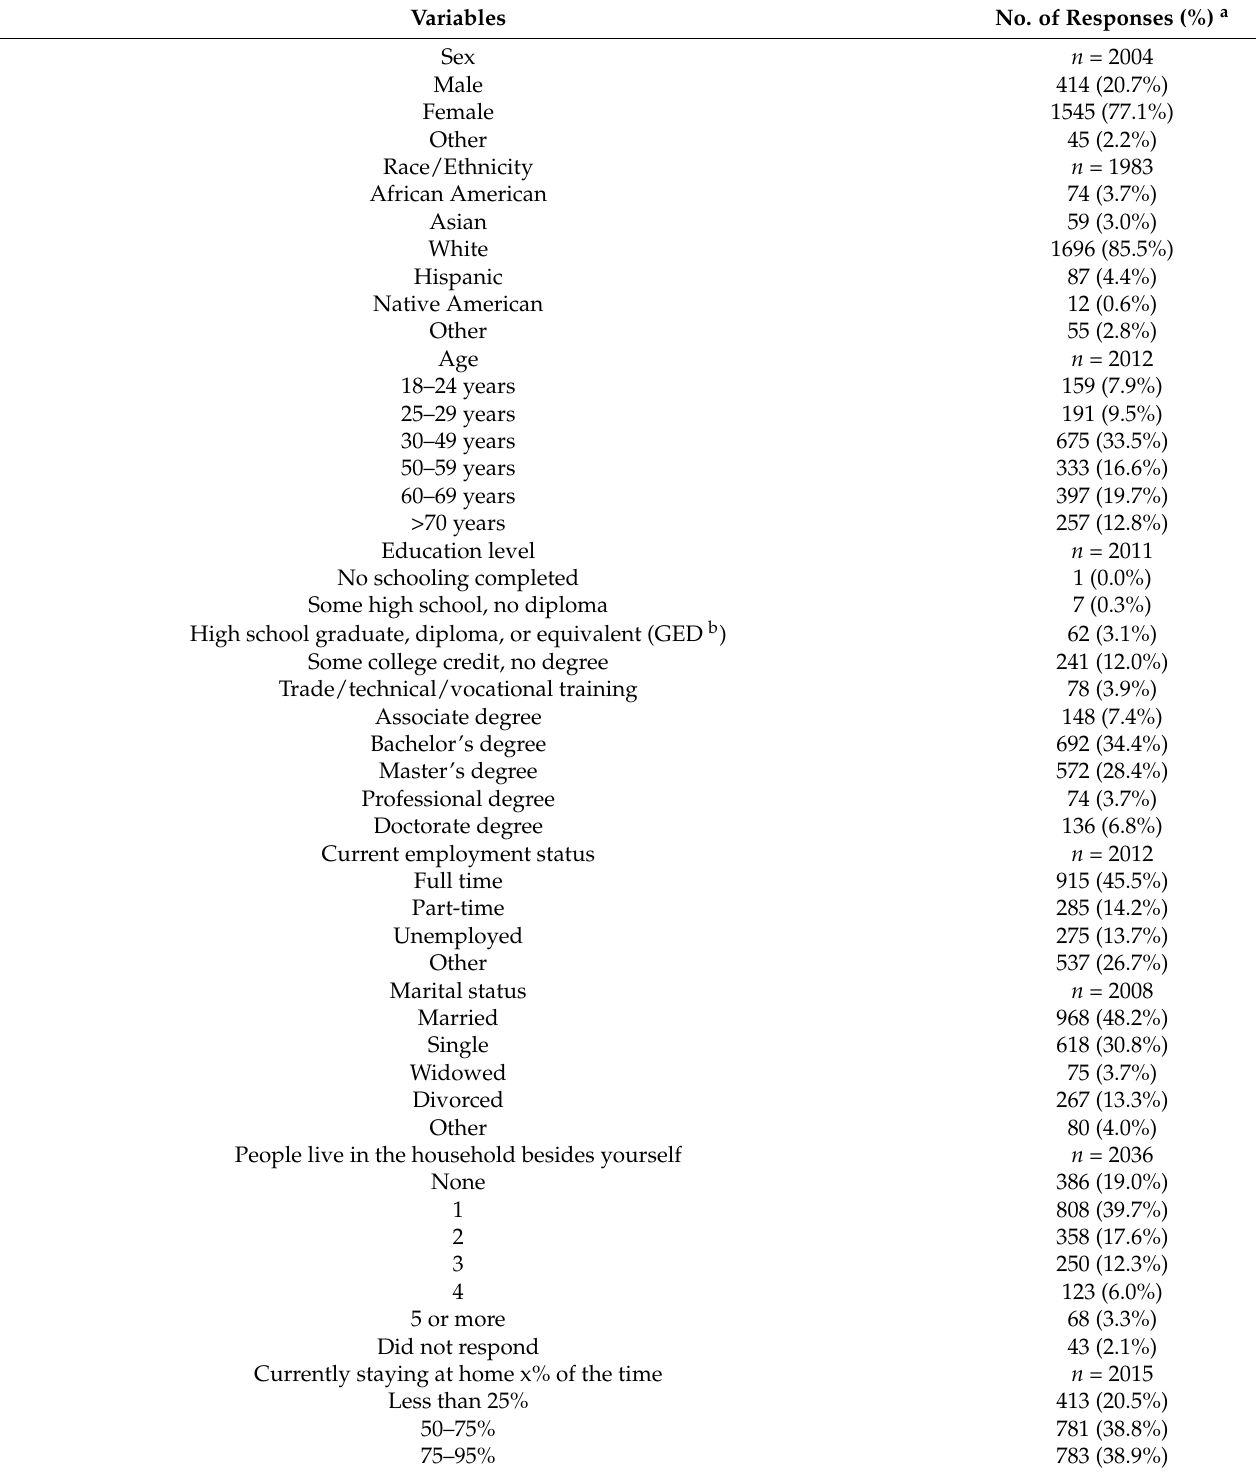
Table 2. Participants’